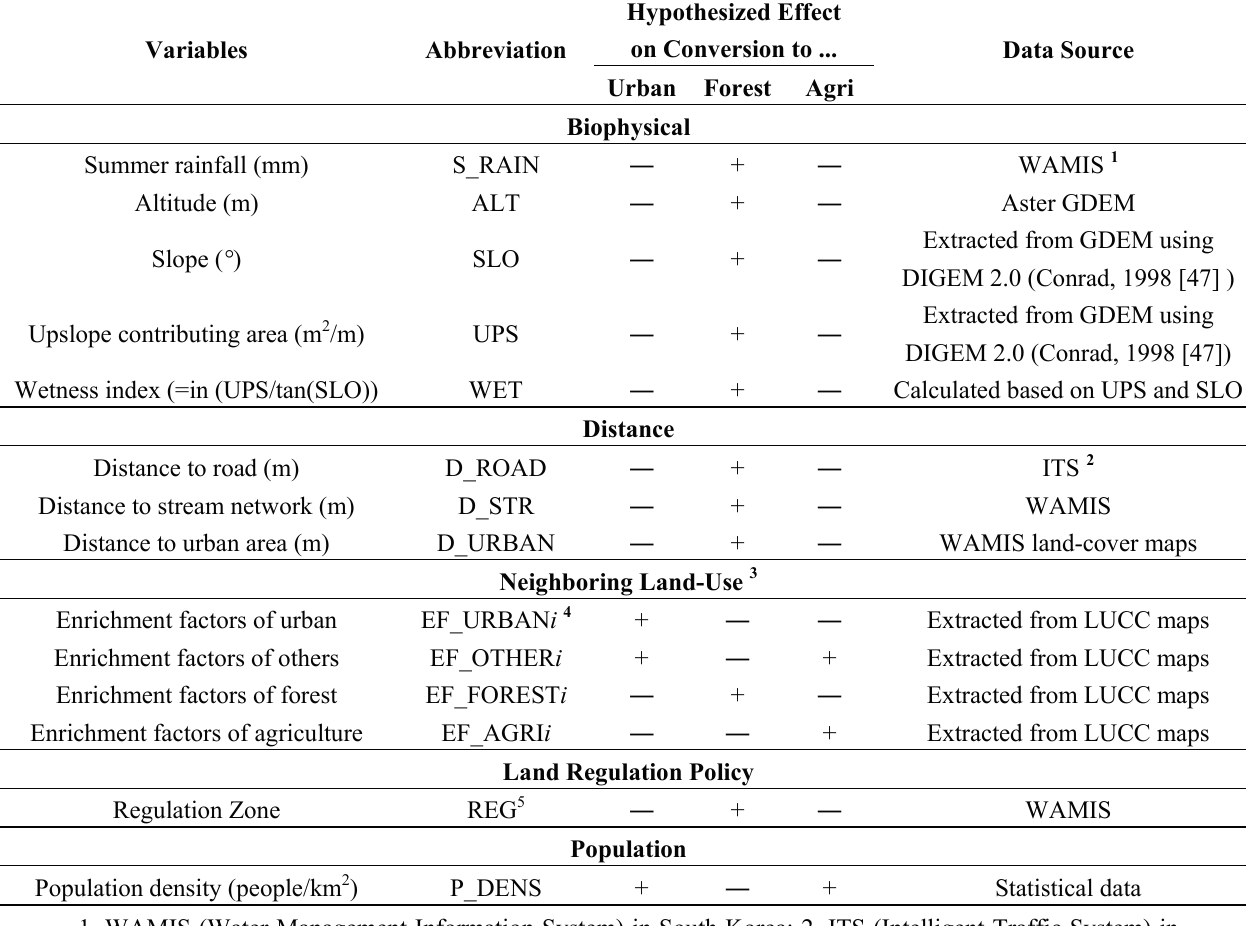
Table 1. Selected explanatory variables, their hypothesized effects, and data